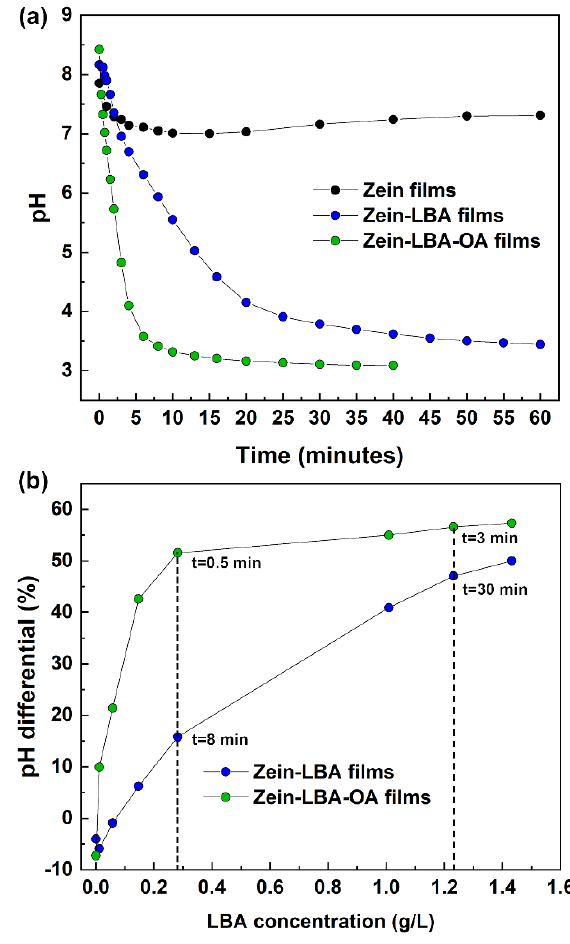
Figure 3. ( a ) Variation of pH of the extraction solution with time for the three films examined. ( b ) The plot of pH differential against LBA concentration in the extraction time at two different stages of the extraction process for both zein-LBA and zein-LBA-OA systems.